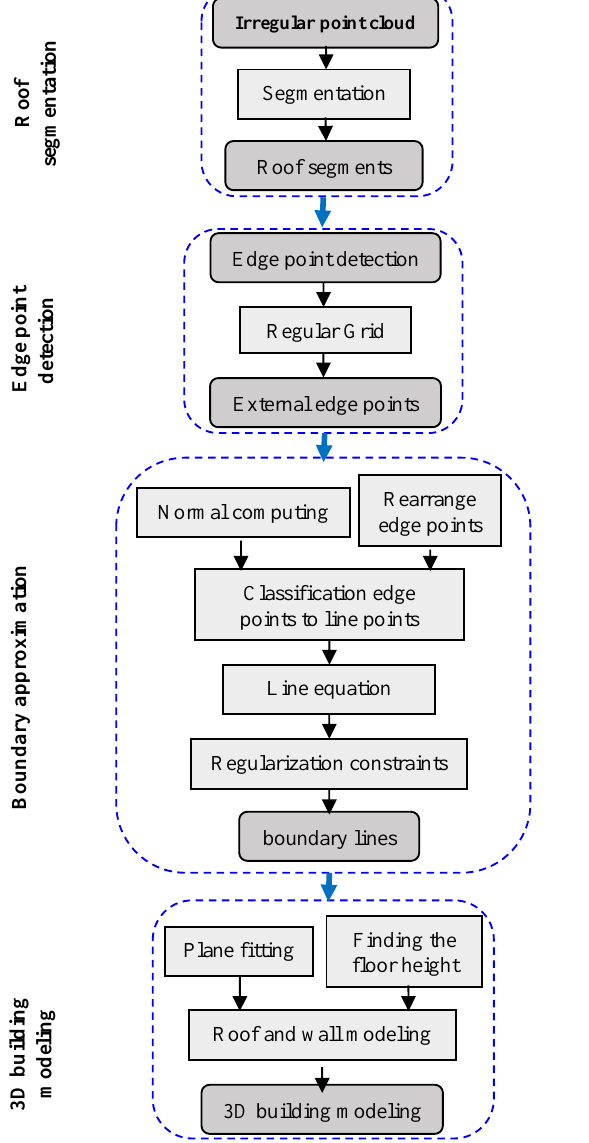
Figure 1. Workflow of the proposed method.